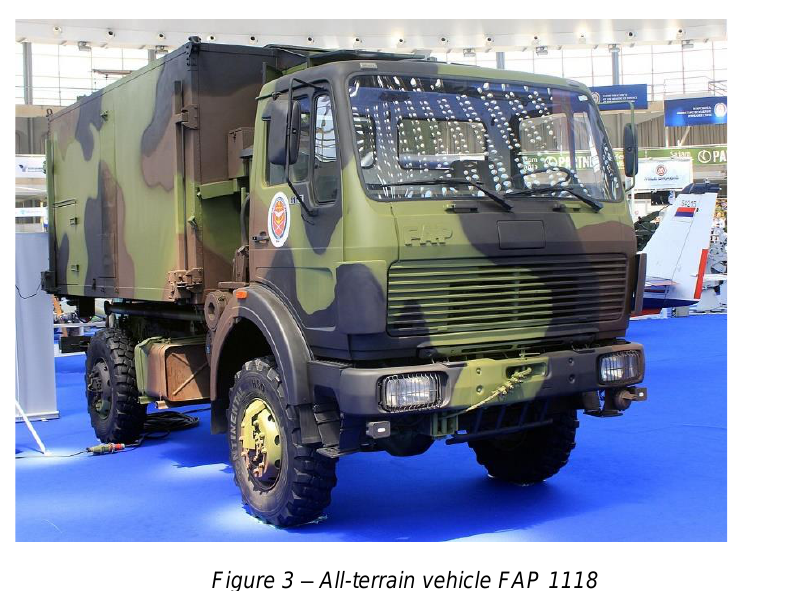
Figure 3 – All-terrain vehicle FAP 1118 Рис. 3 – Крупнотоннажный грузовой автомобиль ФАП